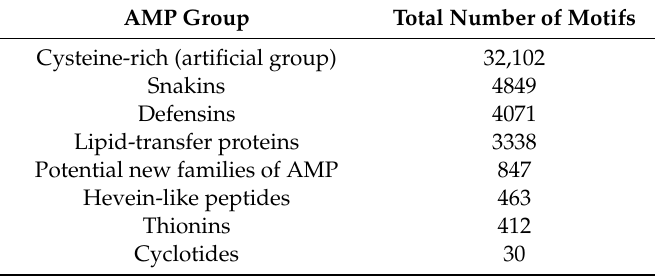
Table 2. Total number of motifs revealed for each peptide group in 1267